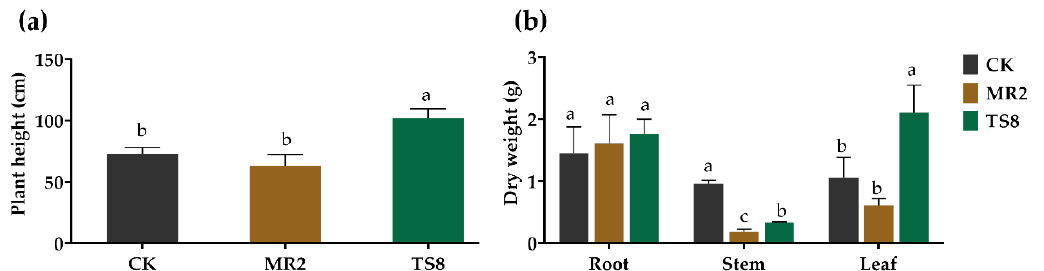
Figure 5. Influence of inoculation with TS8 and MR2 on M. floridulus height ( a ) and dry weight ( b ). “CK,” without PGPB inoculation; “MR2,” Lelliottia jeotgali MR2 inoculation; “TS8,” Klebsiella michiganensis TS8 inoculation. The data were expressed as means ± standard deviation ( n = 3). Different letters represent significant differences between groups at the 5% level (ANOVA and Tukey’s test).